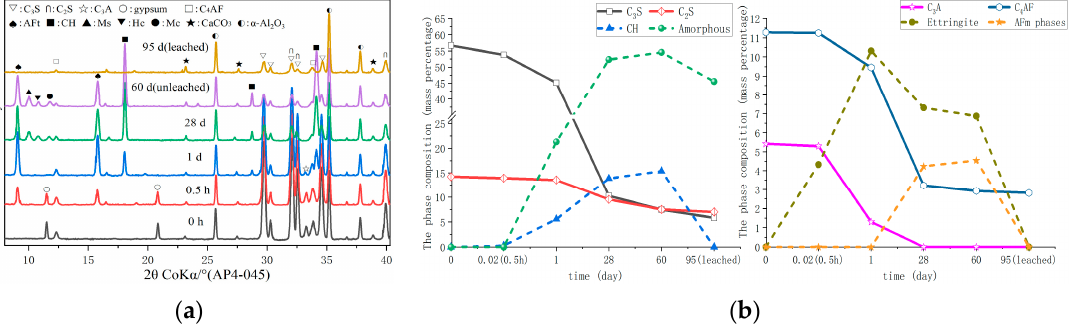
Figure 7. The phase composition of hydrated and leached PA4-045 cement pastes: ( a ) XRD; ( b ) the content of phase composition.